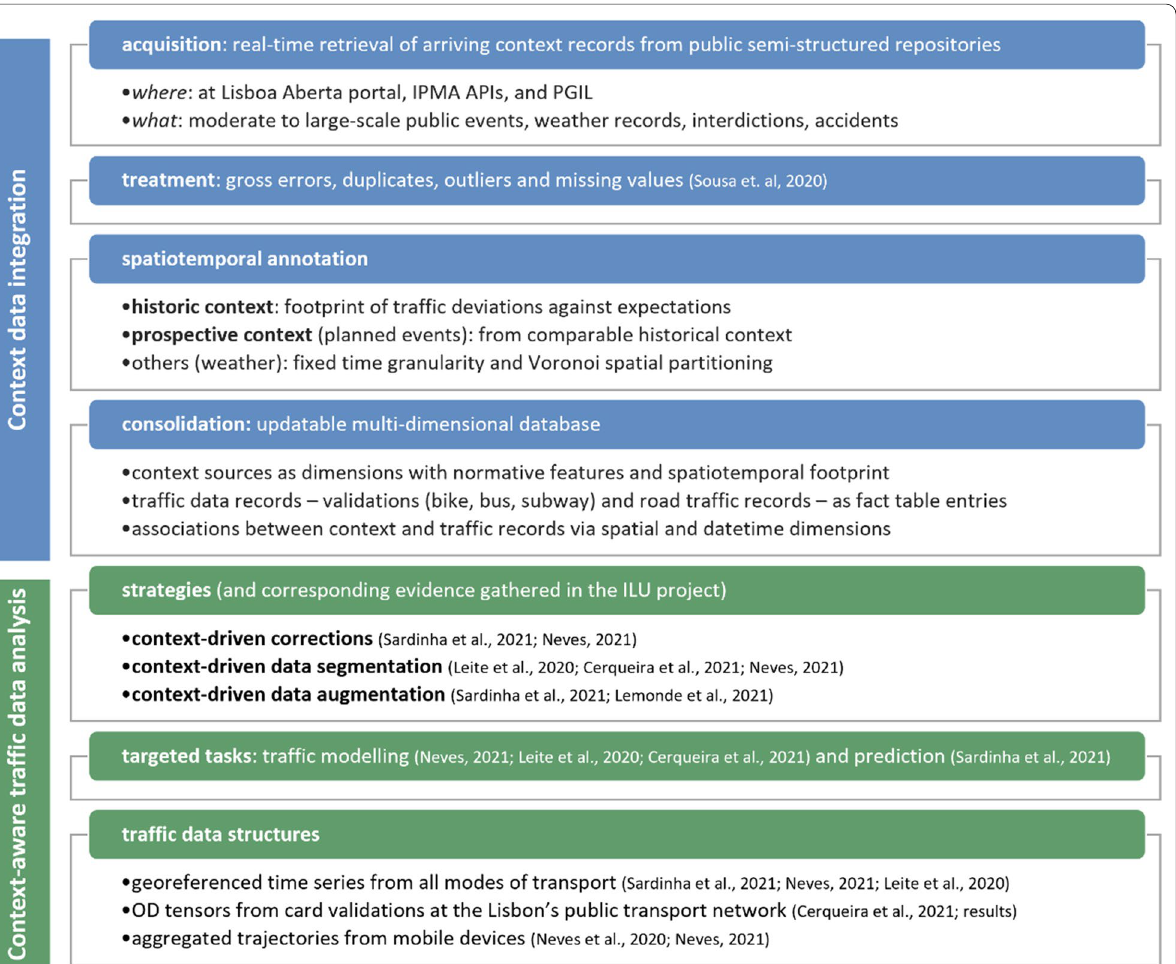
Fig. 2 Pursued principles along the proposed two-step methodology for the context-aware analysis of multimodal traffic data in the Lisbon